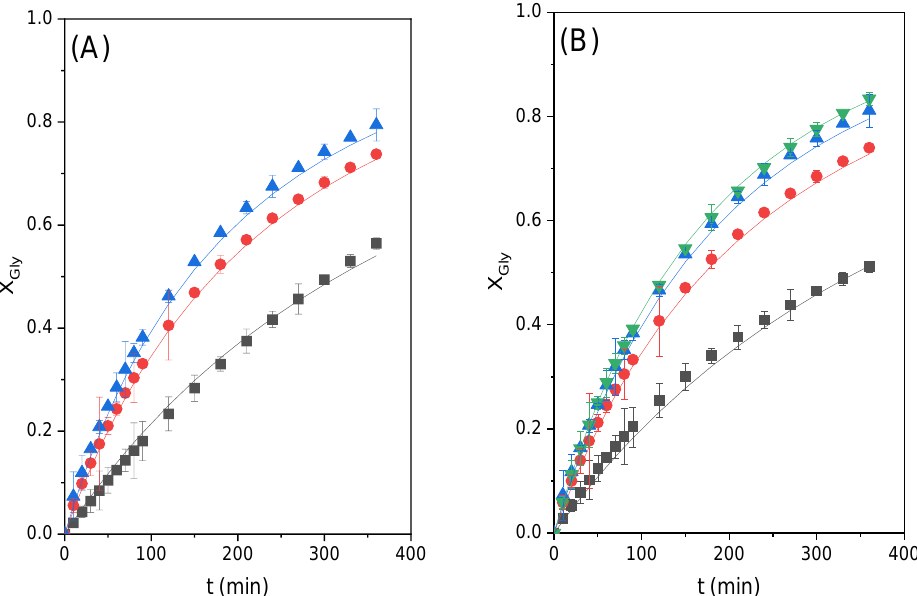
residual sum of squares (RSS), standard error of estimate (S e ), percentage of variation explained